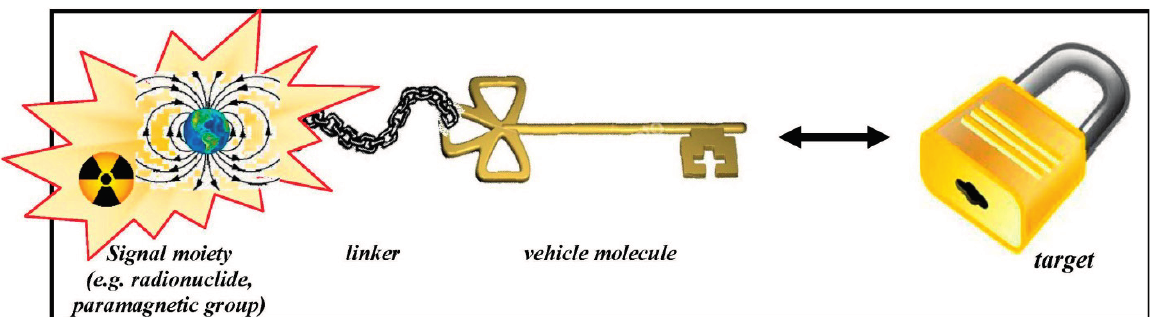
Figure 1. Schematic design of a molecular probe and its interaction with the target